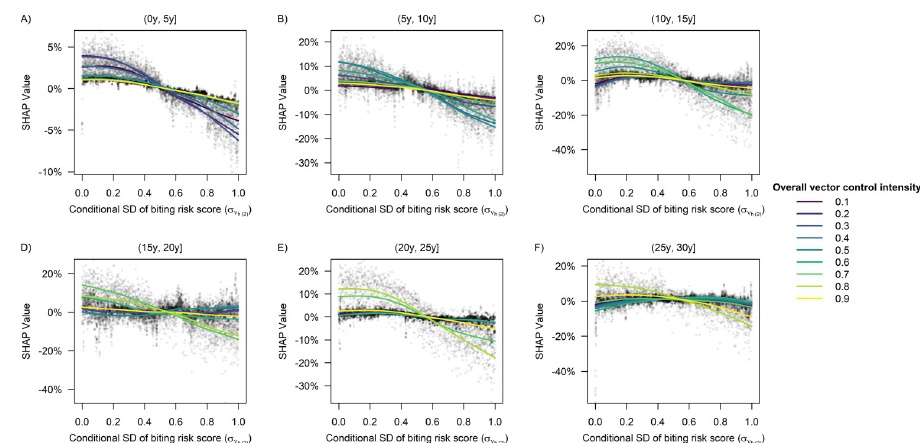
Fig 8. Impact of individual-level heterogeneity in the biting risk score on the predicted vector control effectiveness within each of the following time windows : (A) (0y, 5y], (B) (5y, 10y], (C) (10y, 15y], (D) (15y, 20y], (E) (20y, 25y], (F) (25y, 30y]. The parameter s referred to the standard deviation of the biting risk score controlling for u h ð 2 Þ body surface area. Each point represents a single simulation run, and the SHAP value quantified the change in the predicted vector control effectiveness due to the value of s . Each curve was obtained by fitting a smoothing spline to u h ð 2 Þ the set of data points corresponding to a given overall level of vector control